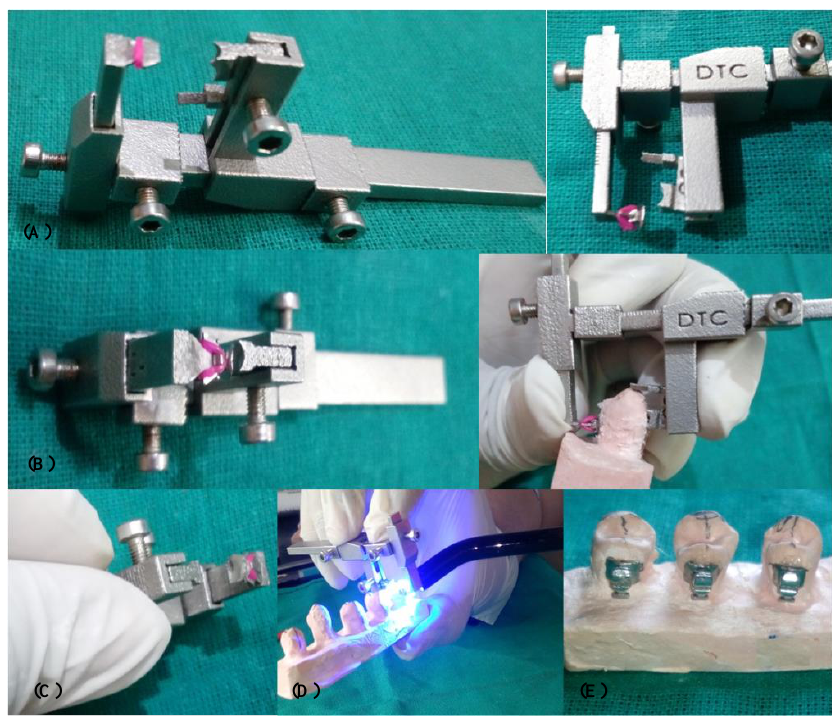
Fig. 4. Placement of brackets on the working model. (A) Lingual and labial attachments are fitted in the DT3C device. (B) The bracket was attached to the DT3C device with the help of the module. (C) Tightening of the screw of the DT3C device on the working model, (D) Adhesive and primer were applied over the bracket base and cured. (E) A working model with bonded brackets.